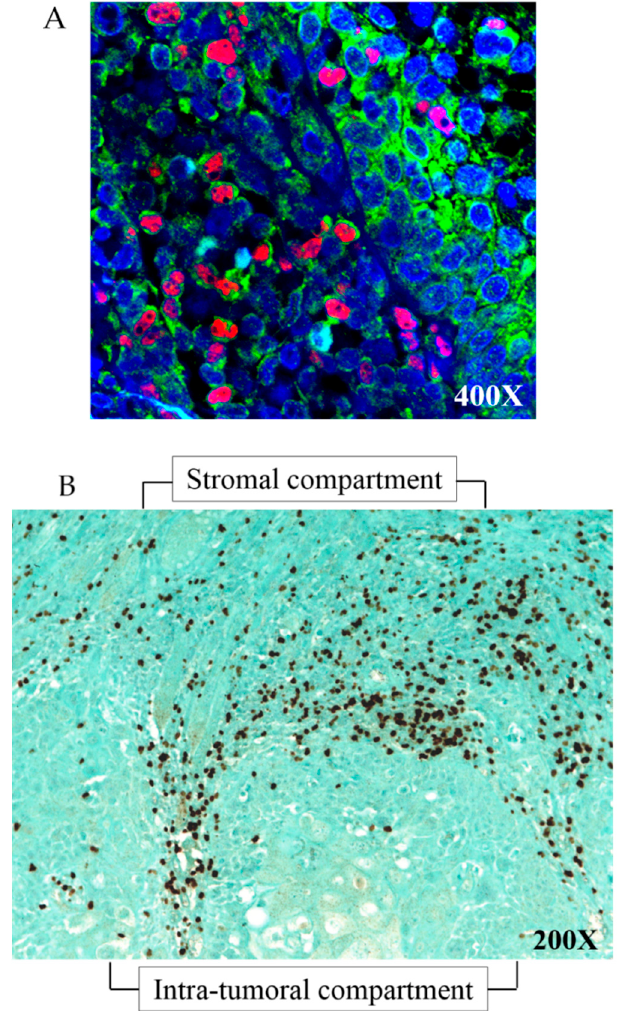
Figure 1. Treg immunostaining on HNSCC tumors. ( A ) FoxP3/CD4 double immunofluorescence on HNSCC tumors. Nuclear red and membrane green fluorescent markers correspond to FoxP3 and CD4 stainings, respectively; blue staining is from DAPI. ( B ) FoxP3 immunohistochemistry in stromal (ST) and intra-tumoral (IT) compartments of HNSCC tumor.